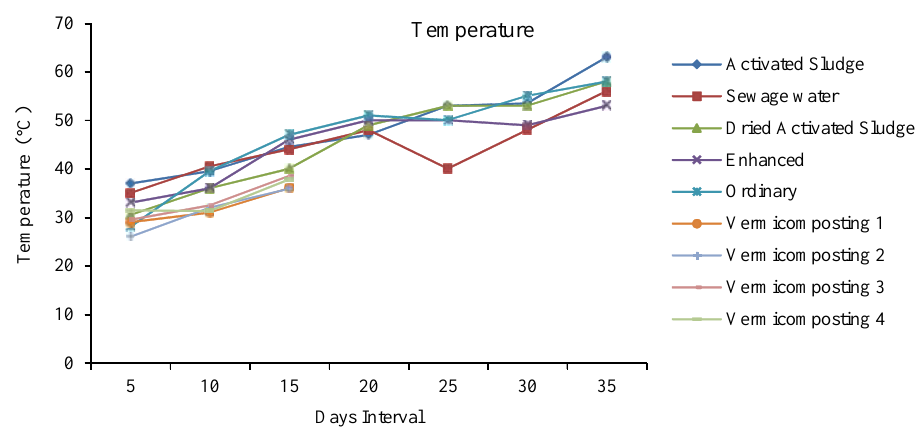
Fig. 5: Comparison of temperature between the initial and final